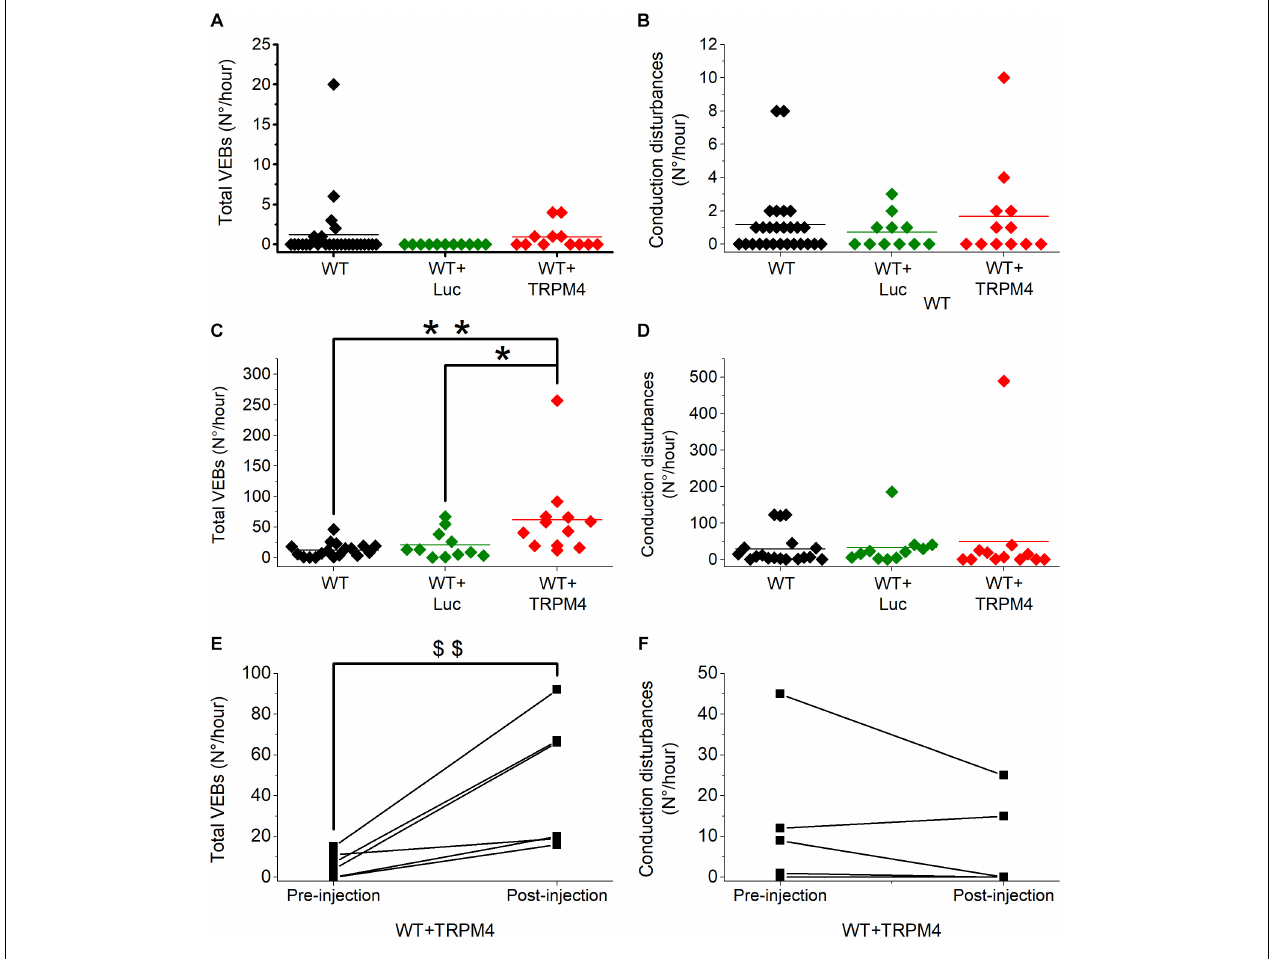
FIGURE 6 | AAV2:9-mediated TRPM4 overexpression increases total number of premature ventricular ectopic beats (VEBs) in freely moving mice during exercise-induced β -adrenergic stress. Solid line indicates mean value. (A,B) Total number of VEBs (A) and conduction disturbances (B) in freely moving WT, WT+Luc, and WT+TRPM4 mice during 1-h nocturnal baseline conditions (WT: n = 27, WT+Luc: n = 11, WT+TRPM4: n = 12; Mann–Whitney test). (C,D) Comparison of total number of VEBs (C) and conduction disturbances (D) in WT, WT+Luc, and WT+TRPM4 mice during exercise-induced β -adrenergic stress (WT: n = 18, WT+Luc: n = 11, WT+TRPM4: n = 12; Kruskall–Wallis followed by a Dunn’s post test, ∗ p < 0.05, ∗∗ p < 0.01). (E,F) Paired analysis of total number of VEBs (E) and conduction disorders (F) before and after injection of TRPM4 during exercise-induced β -adrenergic stress ( n = 6 for each group; Paired t -test, $$ p <